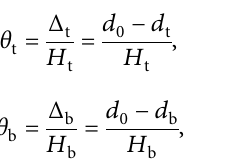
Figure 9: Comparison of predicted and experimental transverse reinforcement ratio. (a) Empirical model proposed by Watson et al. [3]. (b) Empirical model proposed by Sheikh et al. [4]. (c) Our XGBoost model.